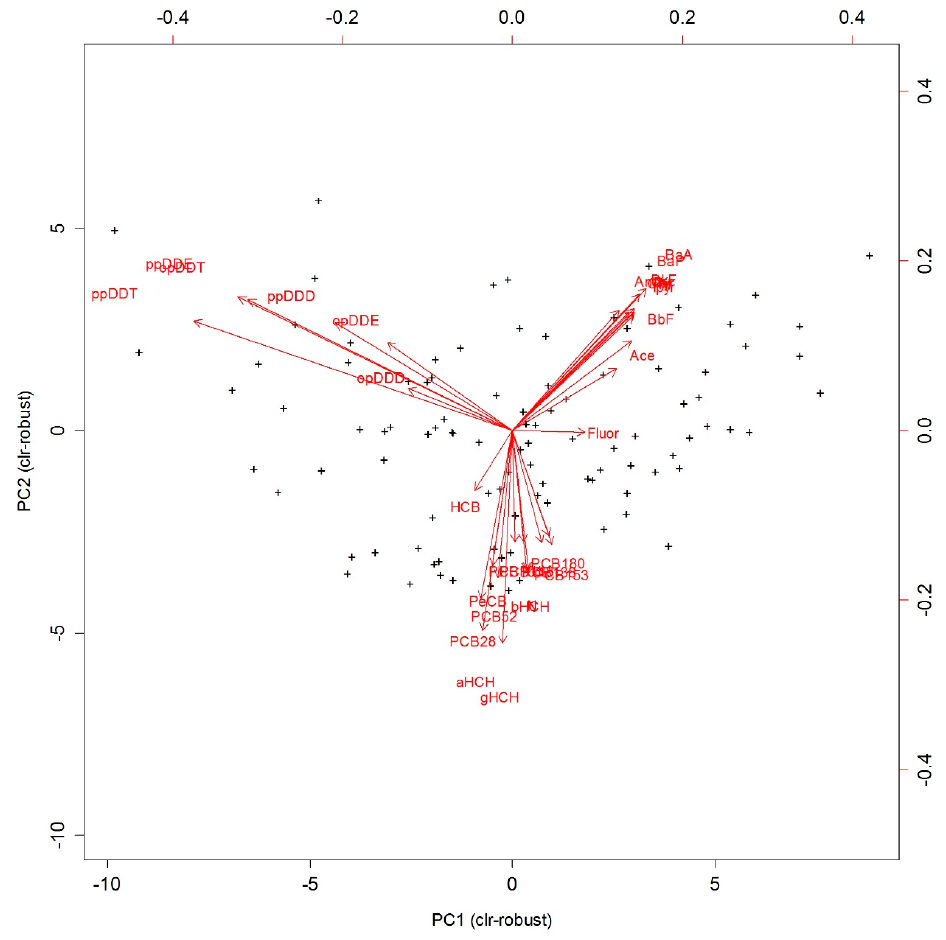
Figure 1. Biplot of the first two robust principal components (PCs) for the centered log-ratio (clr)-transformed major components (explained variation: PC1, 51%; PC2, 20%).